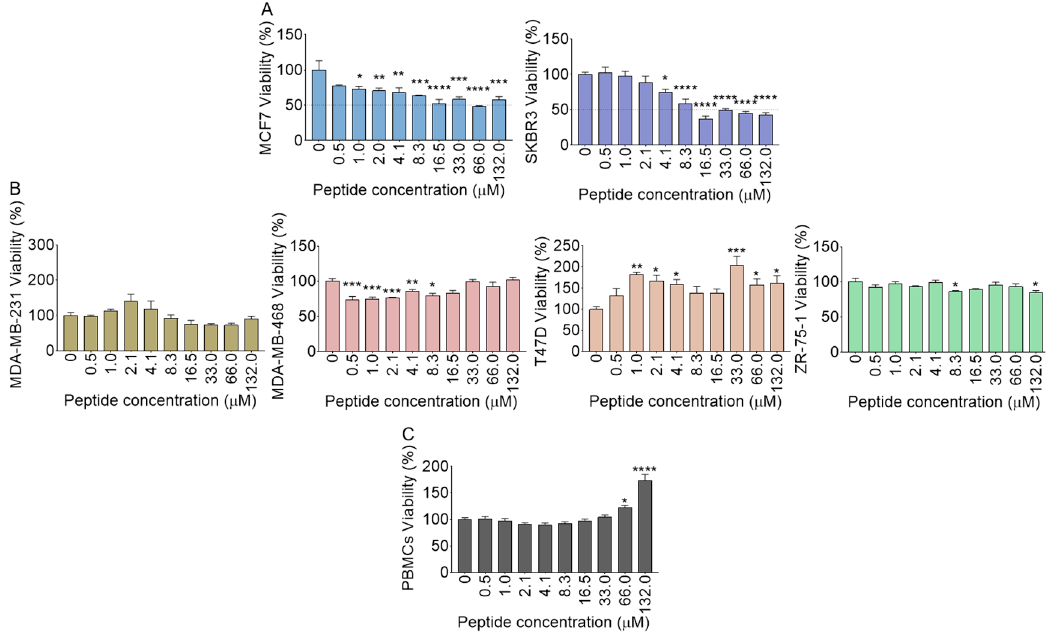
Figure 9. Effect of B18 on cell viability by MTT assay. ( A ) MCF7 and SKBR3 viability. ( B ) MDA-MB-231, MDA-MB-468, T47D, ZR-75-1, and ( C ) PBMCs viability. Experiments were repeated three times with similar results. Error bars represent S.E.M. Ordinary one-way ANOVA test (Dunnett’s correction) was used to determine the differences between each peptide concentration and vehicle (Peptide concentration = 0), whereas * p < 0.05, ** p < 0.01, *** p < 0.001, **** p < 0.0001 and non-significant was not shown for clarity.